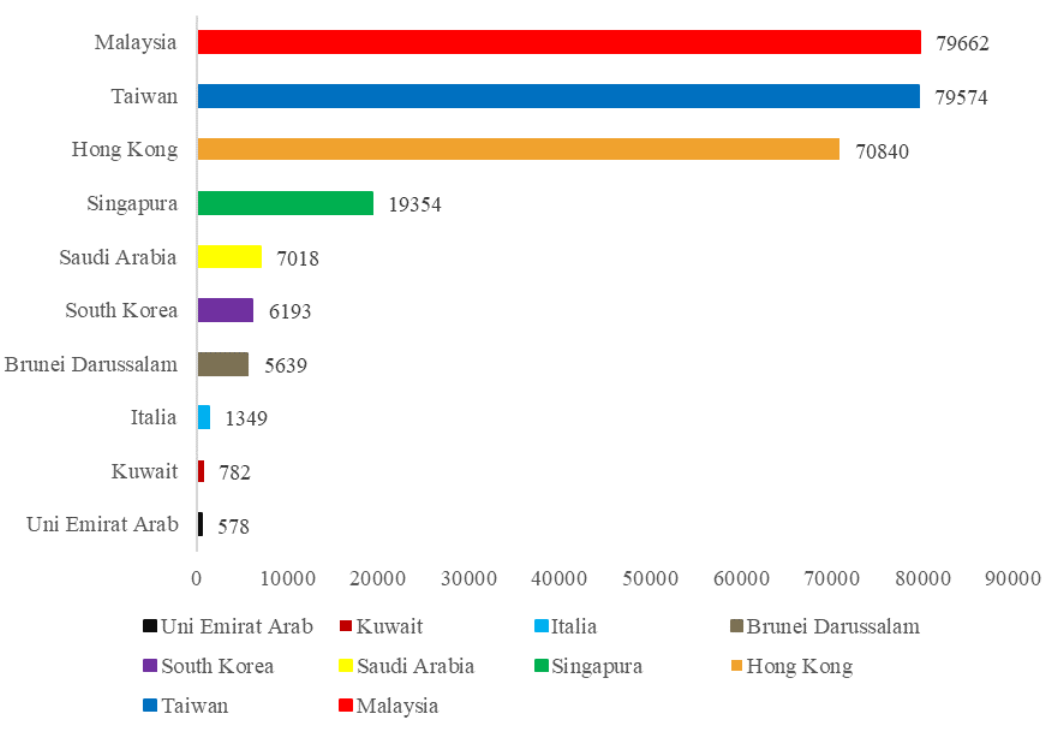
Figure 1.10 Countries with the Largest Placements of Indonesian Workers in 2019